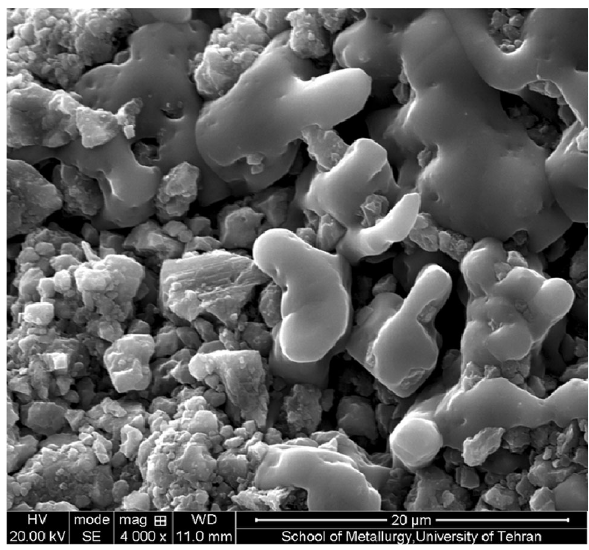
Fig. 8 Crystals of NaCl due to ultrasonic wave